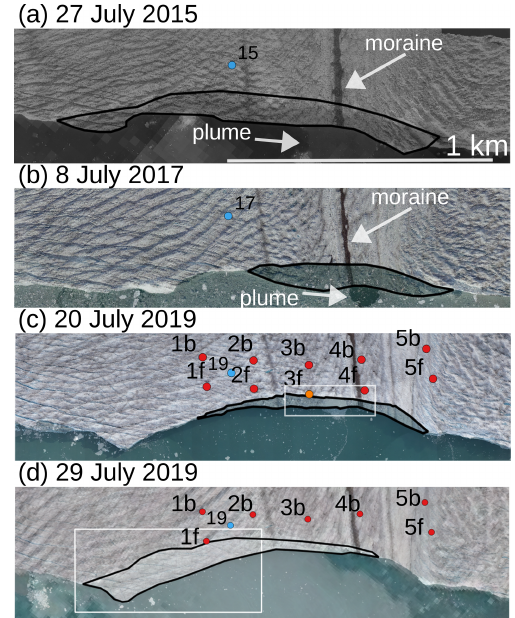
Figure 3. UAV-derived ortho-images of the calving front of Bow- doin Glacier showing large calving events that occurred on 27 July 2015 (a) , 8 July 2017 (b) , 20 July 2019 (c) , and 29 July 2019 (d) . All panels have the same scale and cover the same part of the front (out- lined in Fig. 4a). Pre-calving images are overlaid by 50% transpar- ent post-calving images. Red dots show the GPS stations installed in 2019 ( c and d ; with an orange dot for station 3f that calved off). Blue dots show the position of an additional GPS station installed every year ( a–d ; labelled with the year of operation). Outlines of the calved parts of the glacier in black. White rectangles show the locations of the aerial image and ortho-image in Fig.